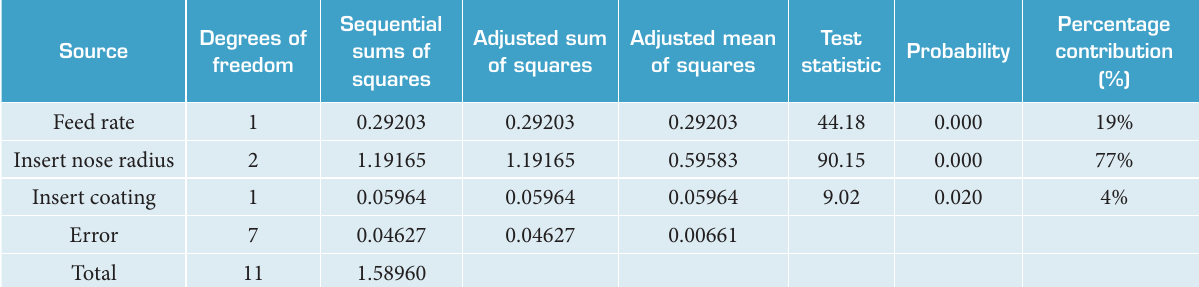
Table 3. Analysis of variance (ANOVA) results for surface roughness.